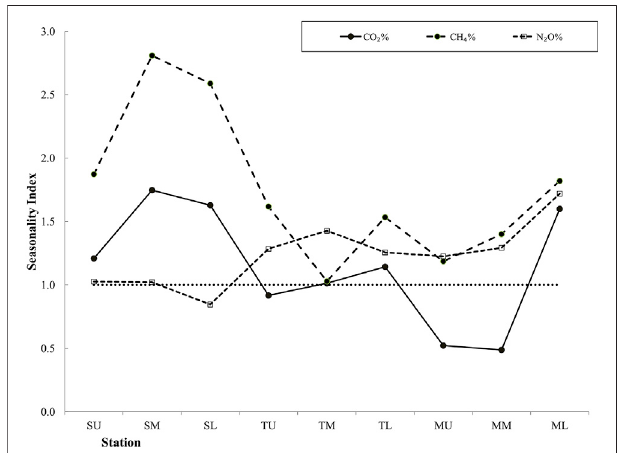
FIGURE 4 | Seasonality index (mean pre-monsoon/early monsoon gas saturation divided by mean late-monsoon/post-monsoon saturations) along the estuary. Study points have been clustered into upper, mid-, and lower regions of the Saptamukhi (SU, SM, SL); Thakuran (TU, TM, TL); and the Matla (MU, MM, ML) for an overview of the seasonality index. Values above a seasonality index of 1 indicate higher pre-monsoon/early monsoon